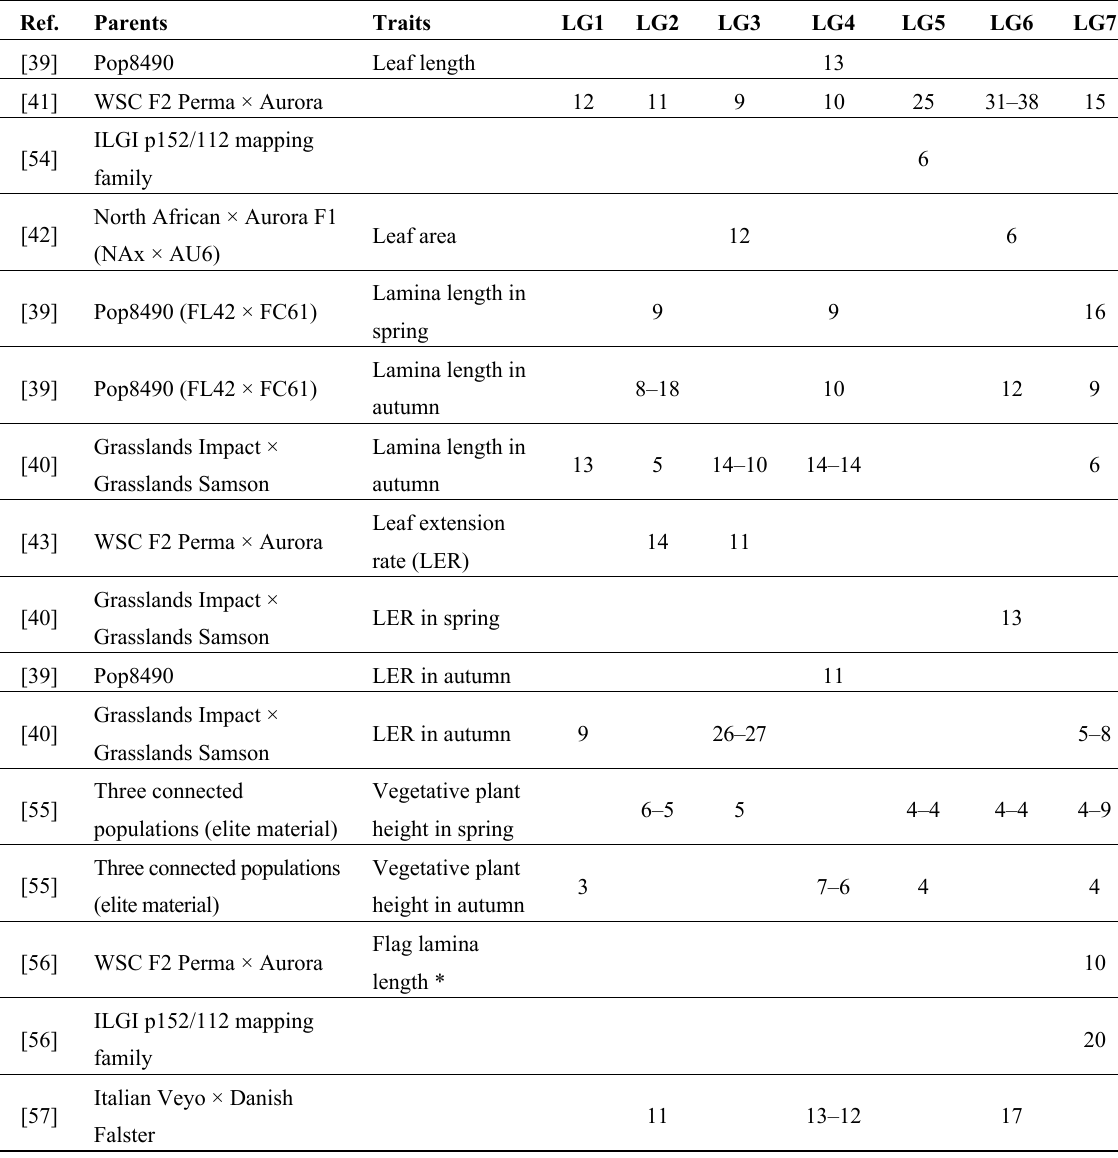
Table 1. QTL for leaf length and related parameters in perennial ryegrass. The percentages of phenotypic variance are given for each linkage group